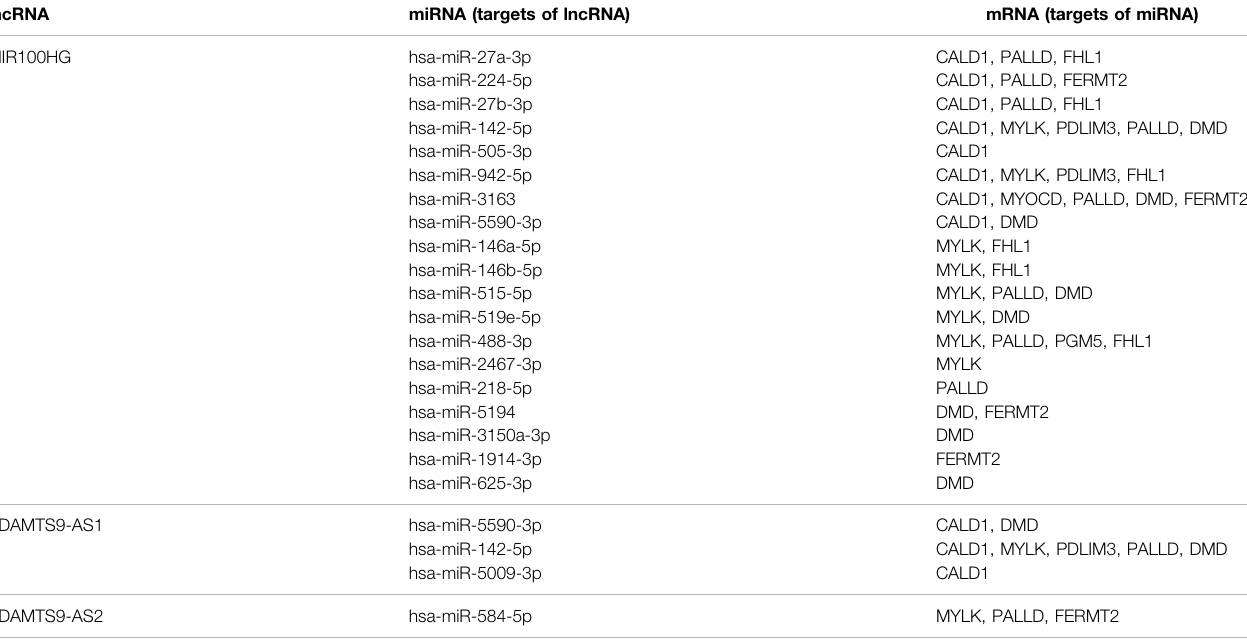
TABLE 4 | RNAS (lncRNAs, miRNAs and mRNAs) in ceRNA network.